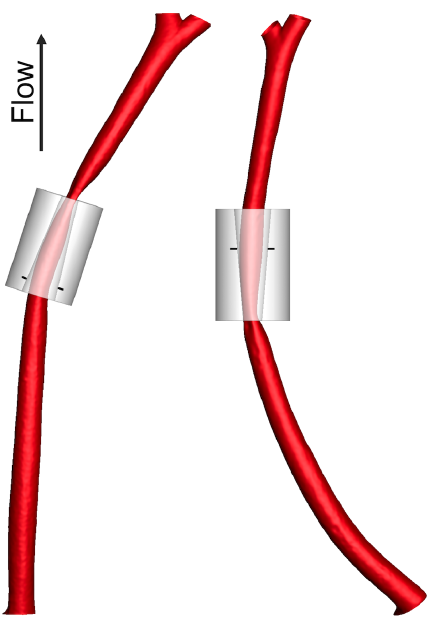
Fig. 1. Reconstruction of cuffed vessels. Reconstruction of the luminal geometry of the left carotid artery from two mice, one with the cuff in the conventional direction (left) and one with it reversed (right). The digital model of the cuff was fitted onto the reconstruction of the corrosion cast by aligning its narrow end with the most restricted point on the cast, and its long axis with the line connecting this point and a point on the cast’s centreline 1.5 mm upstream or downstream for the conventional or reversed cuff orientations, respectively. Marks indicate where the wall would first come into contact with the forward cuff or would last be in contact with the reversed cuff, assuming wall thickness is 10% of luminal